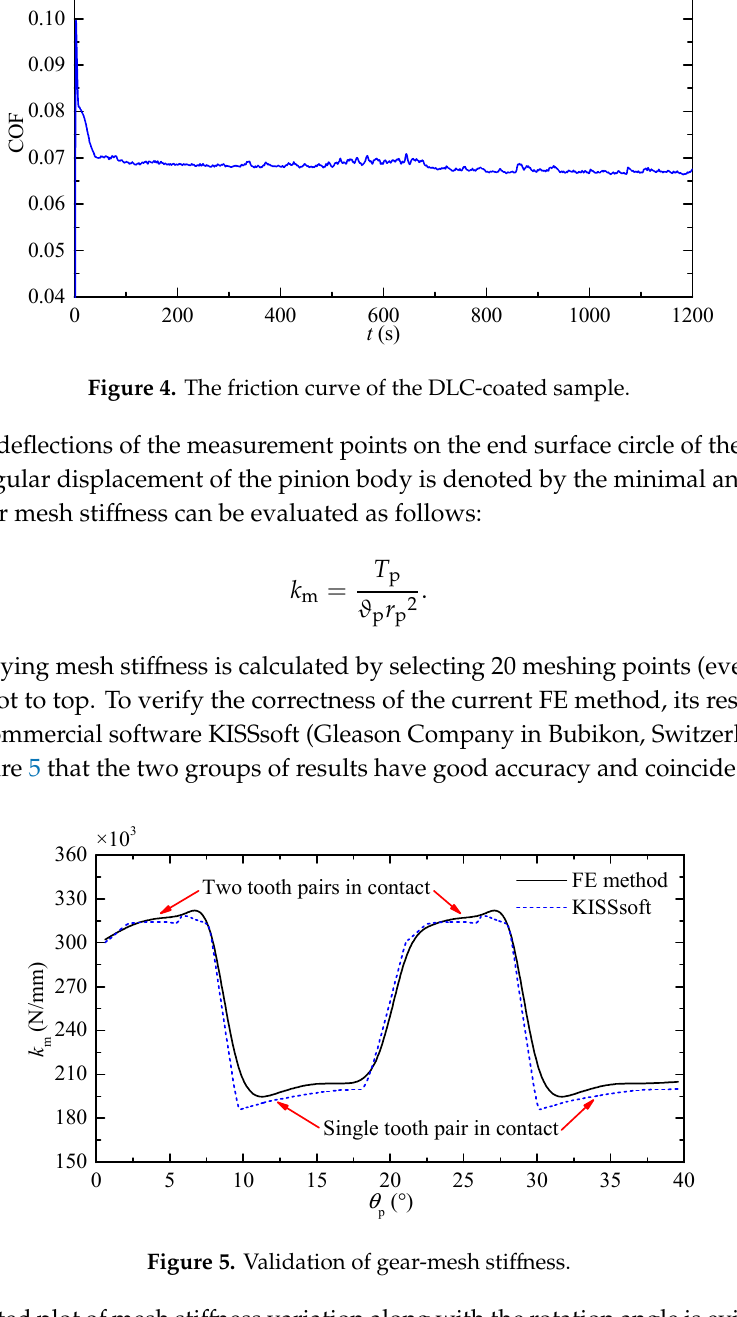
Figure 5. Validation of gear-mesh stiffness.